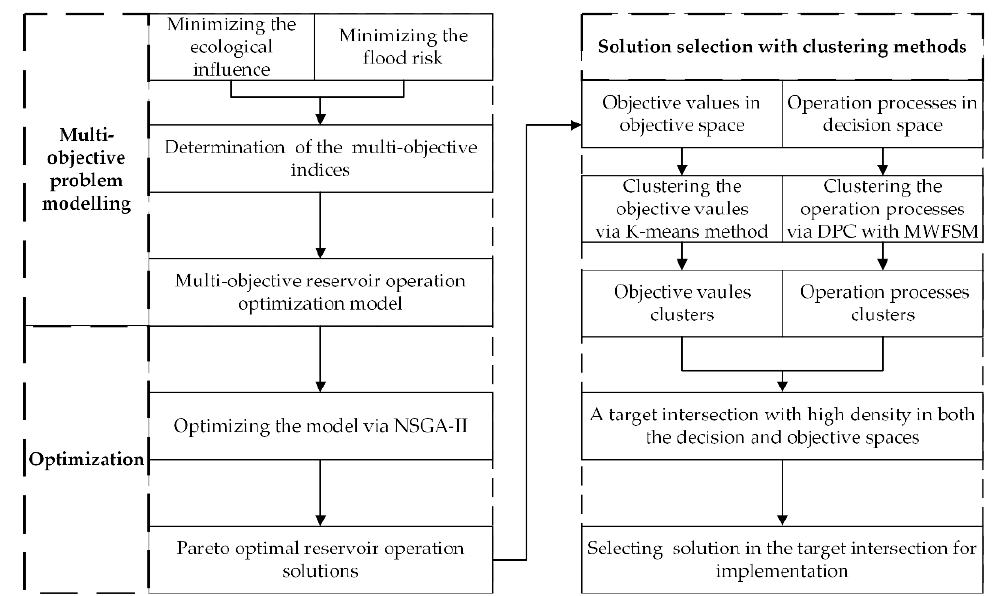
Figure 2. Procedure of the clustering-based solution selection method.